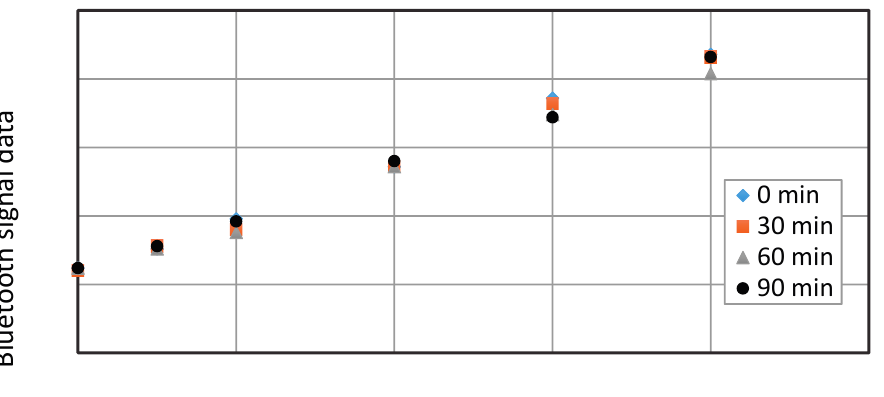
Figure 9. The repeatability test results of the glucose